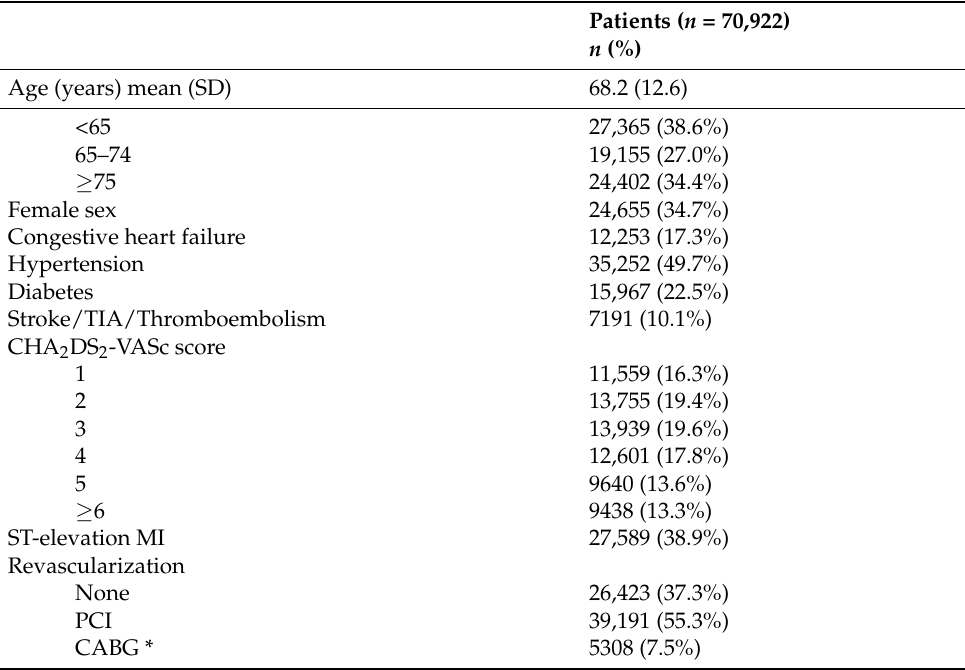
Table 1. Baseline features of study